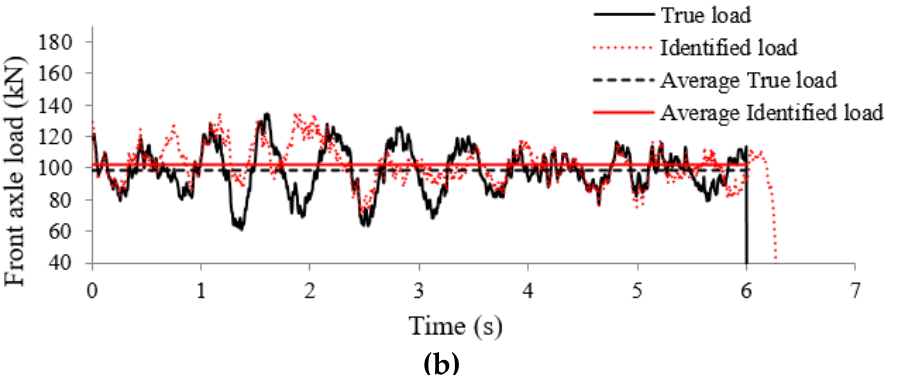
Figure 10. Identified loads at road roughness level B, speed 15 m/s and 2% noise: ( a ) rear axle load identification, ( b ) front axle load identification.